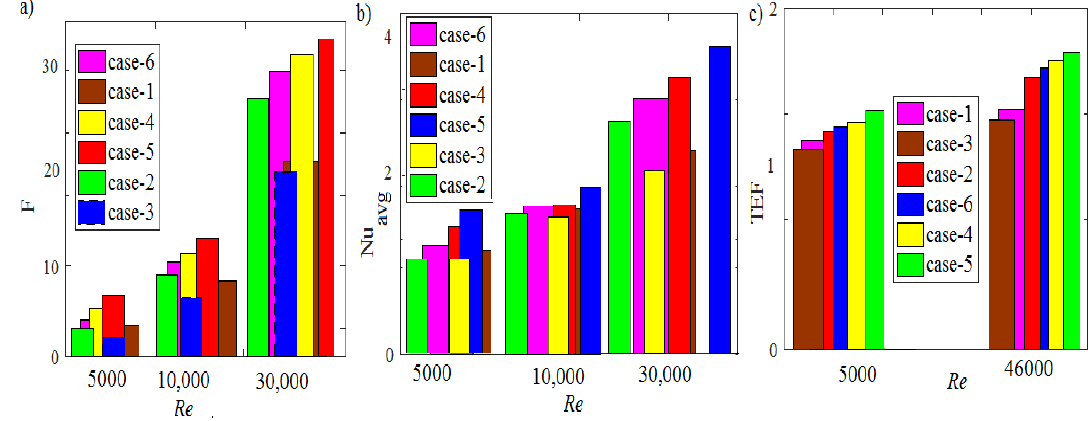
Figure 8. Profiles of F (a), Nu avg (b) and TEF (c) with different Re for different